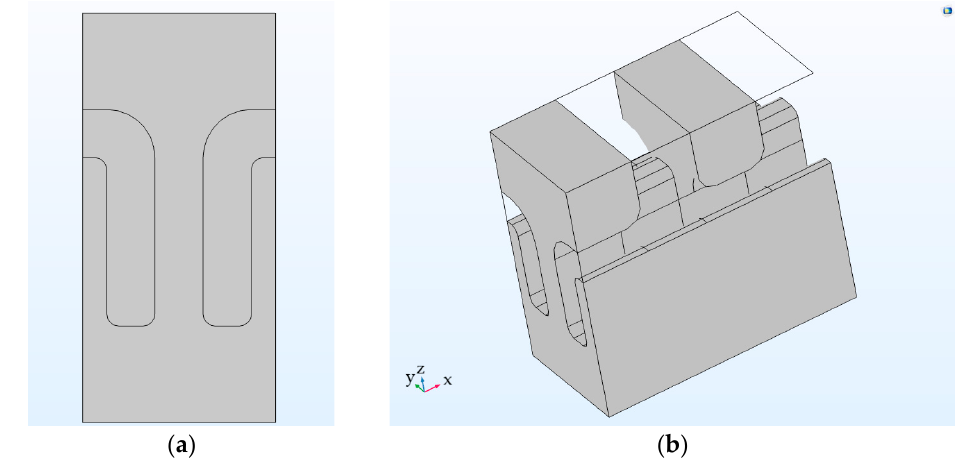
Figure 13. ( a ) Cross-section of ∩ -type lower channel; ( b ) perspective of ∩ -type lower channel.